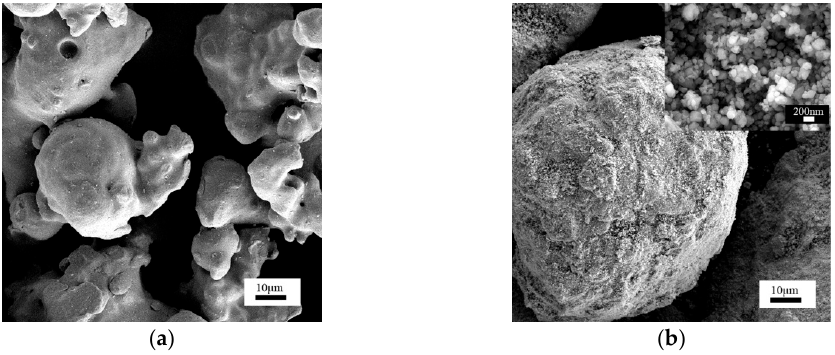
Figure 2. ( a ) SEM image of iron powders; ( b ) SEM image of coated iron powders.